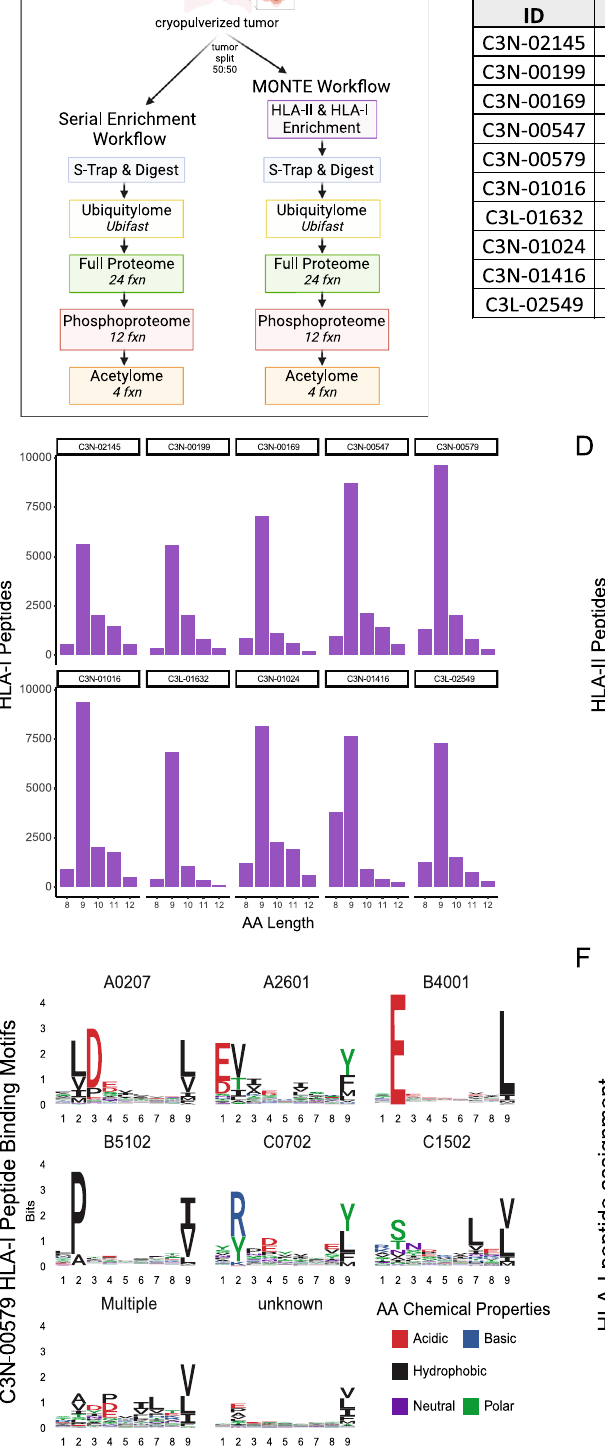
distributions of HLA-II peptides from the LUAD cohort. E Example HLA-I pep- tide binding motifs and the alleles expressed by LUAD Patient C3N-00579. F Example HLA-I peptide-allele assignments to individual HLA-A, -B, -C alleles or combinations of these alleles obtained using the presentation predictions from HLAthena for three LUAD patients 7,8 . Source data for C , D , and F are provided as a Source Data fi